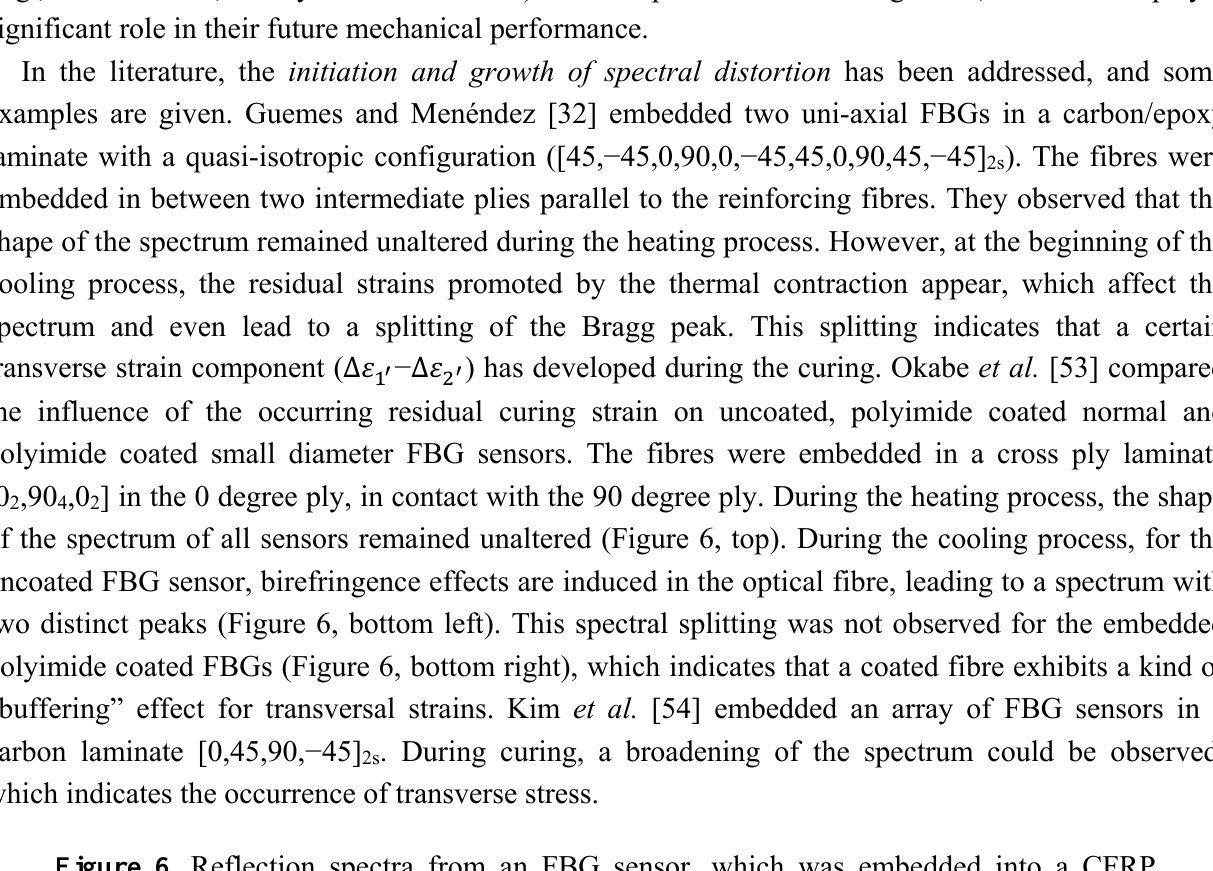
Figure 6 . Reflection spectra from an FBG sensor, which was embedded into a CFRP laminate, measured during the cure cycle. (top) During the heating process and (bottom) during the cooling process, (bottom left) for an uncoated sensor, (bottom right) for a coated sensor